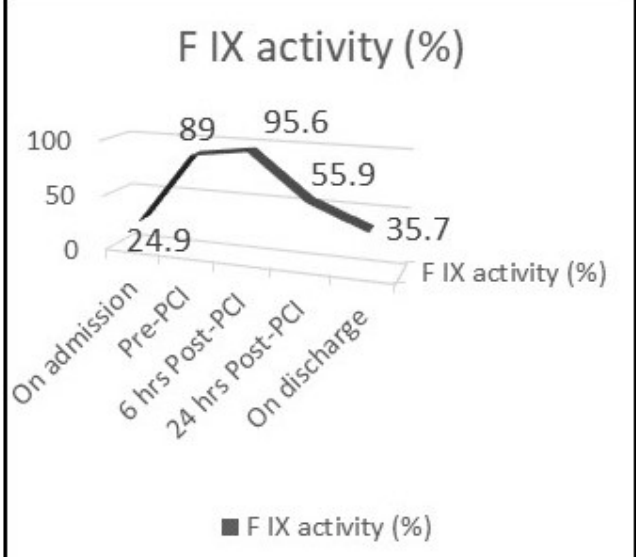
Figure 2. Plasma Factor IX activity before, during and after percutaneous coronary intervention (PCI).